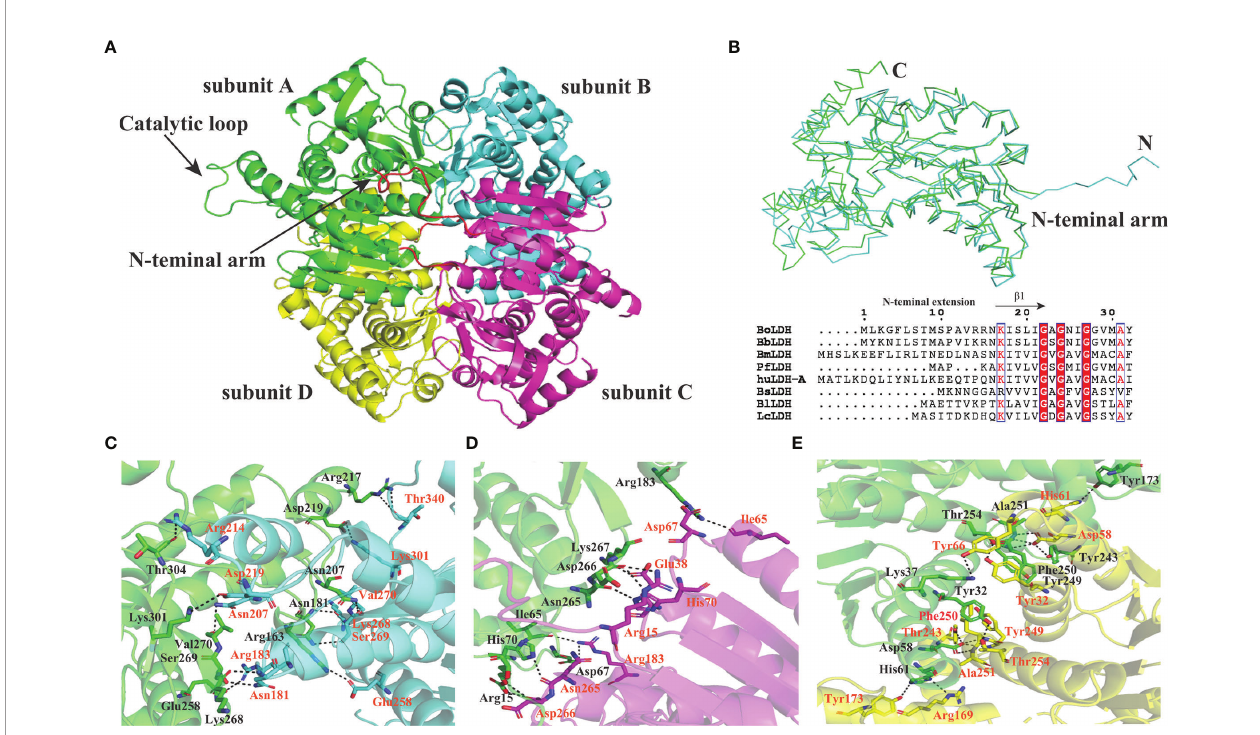
FIGURE 6 | Subunit interfaces of BoLDH. (A) The tetrameric state of BoLDH. BoLDH consists of four identical subunits, and colored in green, scan, magenta and yellow, respectively. (B) Comparison between apo Bi fi dobacterium longum (Bl) LDH (1lld) and BoLDH. The apo BoLDH (scan) were superimposed on and BlLDH without ligands (green). (C) The interface of subunit A and subunit B. Carton models of subunits A and B are displayed in different colors (green and scan). (D) The interface of subunit A and subunit C. Carton models of subunits A and C are displayed in different colors (green and magenta). (E) The interface of subunit A and subunit D. Carton models of subunits A and D are displayed in different colors (green and yellow). The dashed lines represent the hydrogen bonds and salt-bridges between the respective donor and acceptor atoms. These pictures were produced using the software PyMOL